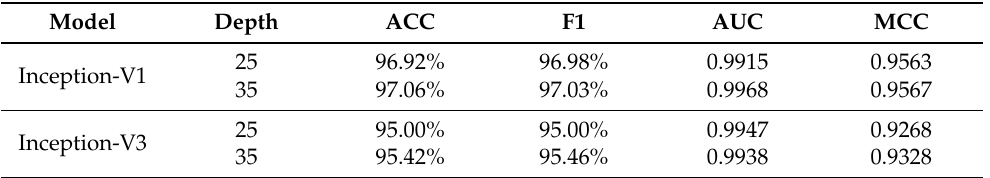
Table 7. Soft-voting ensemble models—Overall performance for three-way classification models in terms of balanced accuracy, macro F1, macro AUC, and multiclass Matthews Correlation Coefficient (MCC) for both Inception-V1 and Inception-V3 for a depth size of 25 and 35